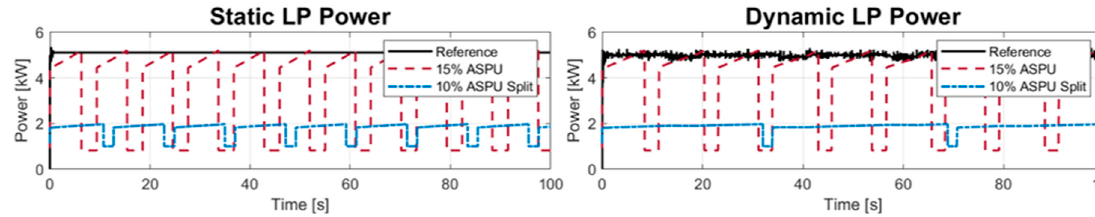
Figure 16. Power consumption of three evaluated systems accounting for tertiary control pump. Table 6. Summary of power consumption and savings.